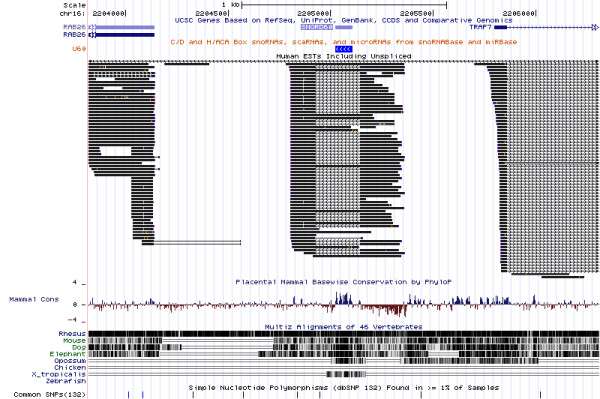
Screenshot of UCSC Genome Browser for the SNORD60 locus to demonstrate presence of many unspliced ESTs.